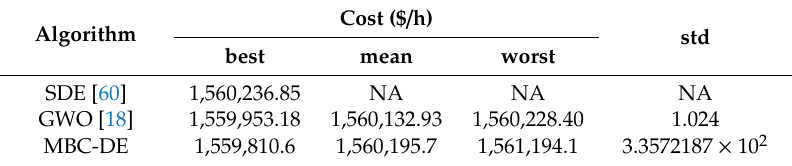
Table 16. Algorithms comparison between MBC_DE and other algorithms for test case